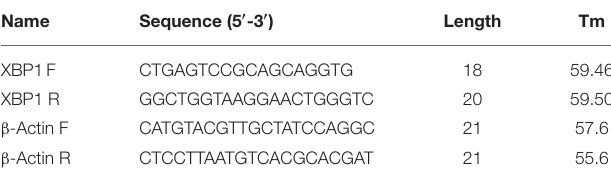
TABLE 1 | Oligonucleotide primer sets for quantitative real-time PCR